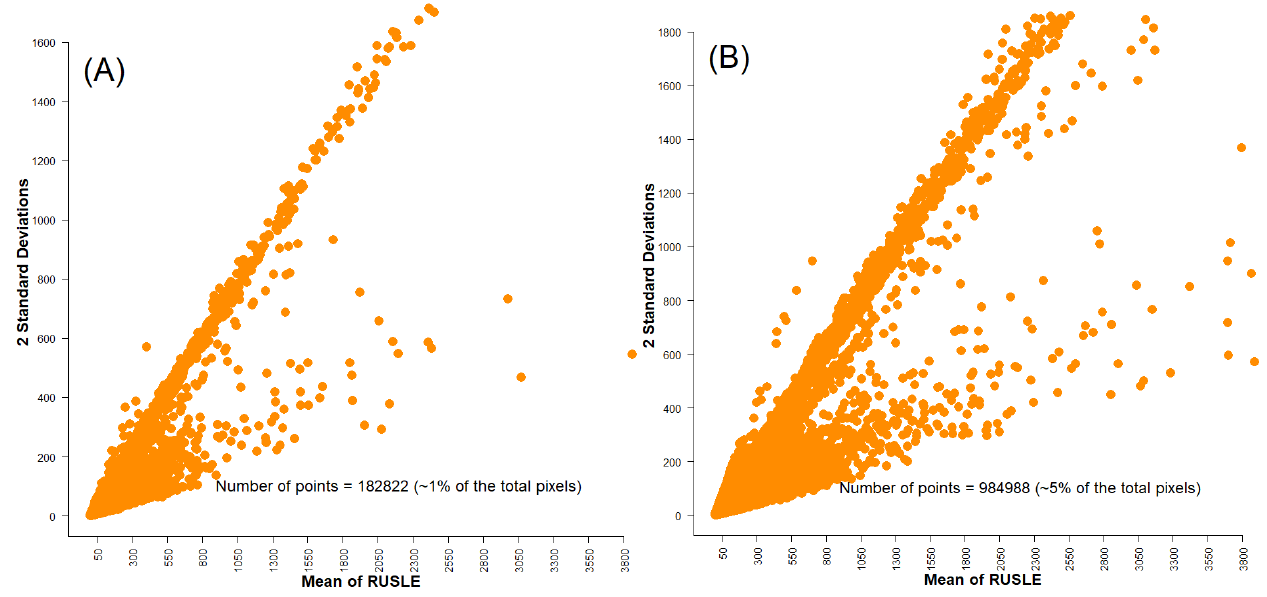
Figure 15. Uncertainty plots show the mean value of the eighteen RUSLE scenarios (x-axis) against two standard deviations of the eighteen RUSLE scenarios (y-axis); 124 outlier pixels of the RUSLE were removed, which are >5000 t · ha − 1 · y − 1 for ( A ) ~1% and ( B ) ~5% of the total pixels was used.